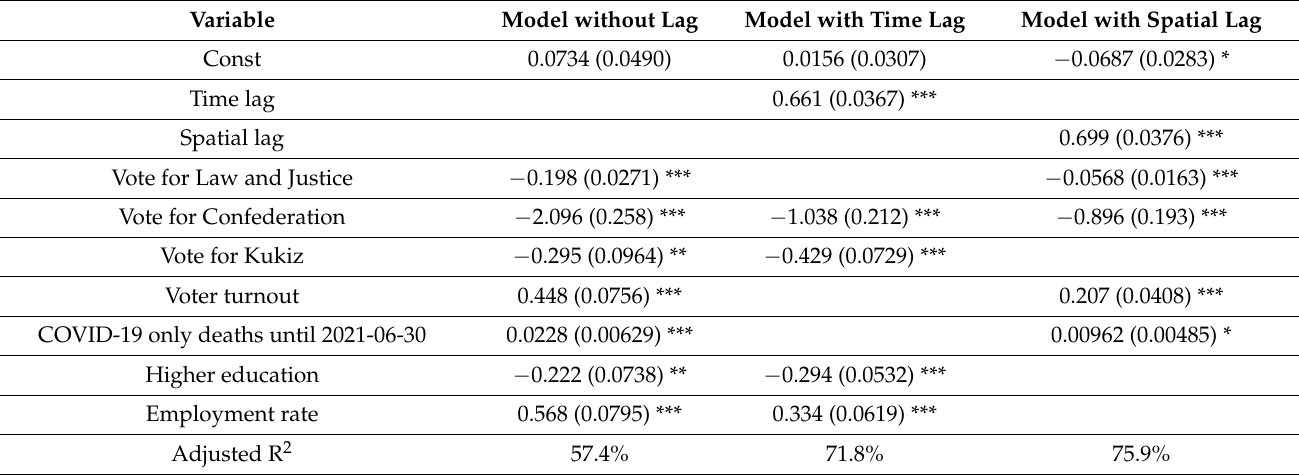
Table 2. Percentage of remaining population in age group 40–59 that were vaccinated against COVID-19 between 30 June 2021 and 31 January